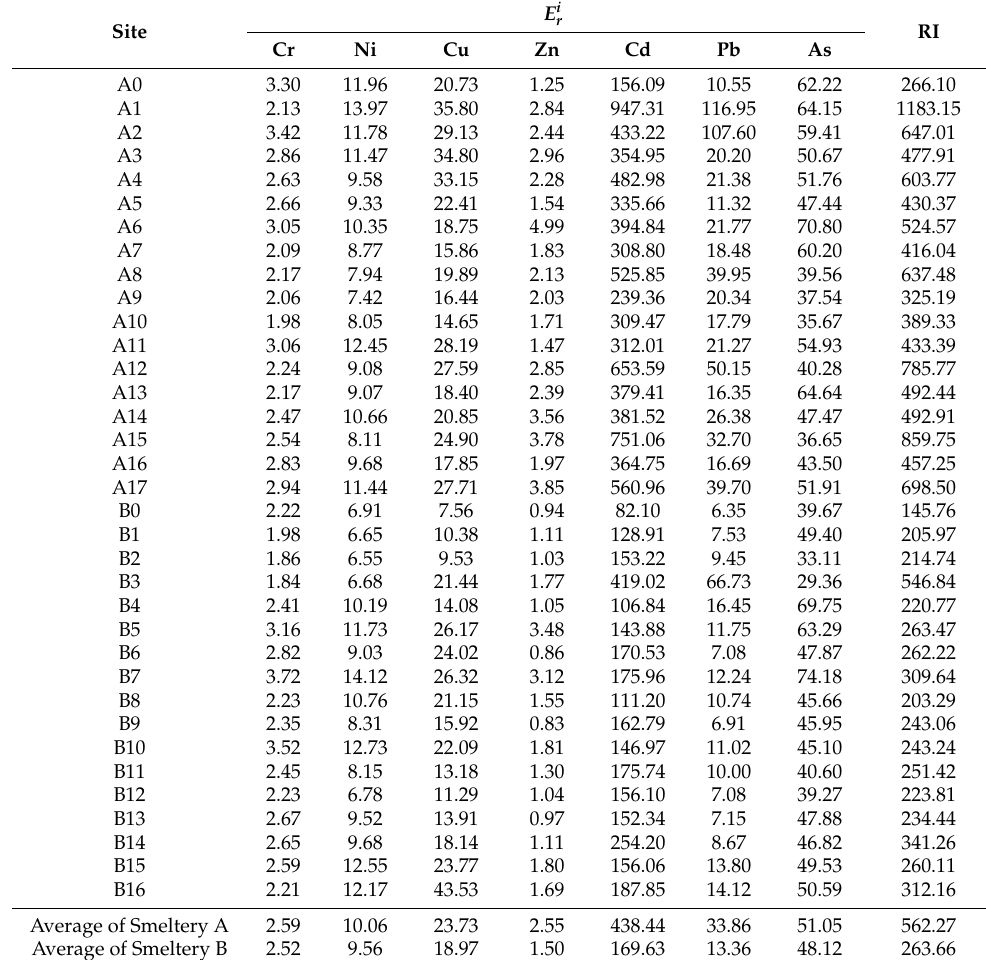
Table 5. Potential ecological risk assessment of metals in